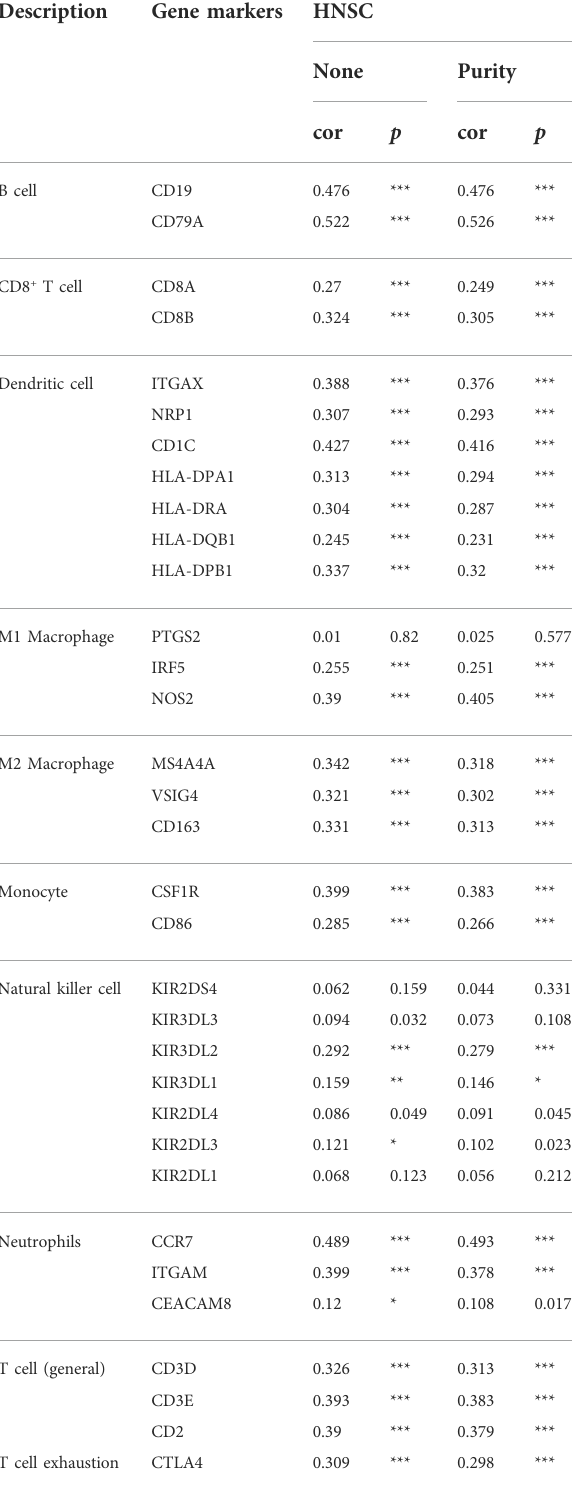
TABLE 3 The relevance between INMT and the biomarkers of immune cells in HNSC was analyzed utilizing the Timer platform.